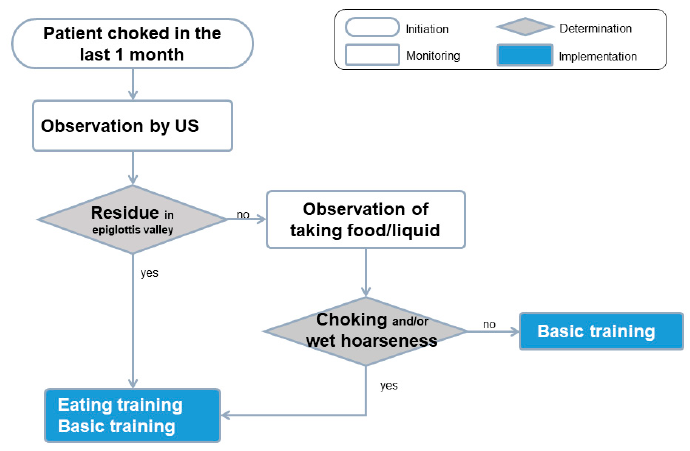
Figure 2. The swallowing care algorithm including ultrasound observation.